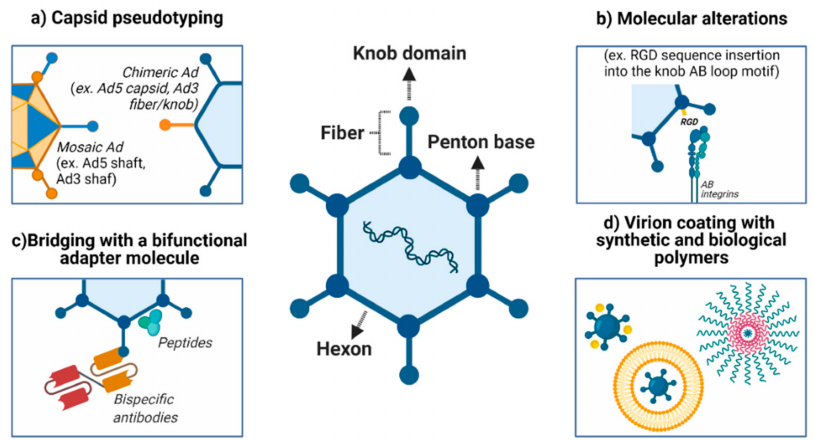
Figure 1. Improvements in vector delivery to and targeting of cancer cells. ( a ) Several approaches can be used to modify viral attachment and entry, such as inhibiting the binding to natural re- ceptors (detargeting) and creating tropism for neoplasms and their metastatic foci (retargeting). ( b ) An alternative to CAR-mediated viral attachment is modifying the fiber (for example, incorpora- tion of the RGD sequence into the knob AB-loop motif). ( c ) Ad structure permits retargeting through the incorporation of synthetic molecules and antibody fragments within the virus capsid. ( d ) Both biological (e.g., cell membrane, liposome) and chemical (e.g., gold, silver, PEG) approaches may be used to coat the virus and improved delivery, especially for the systemic route. PEG: polyethylene glycol. Created with